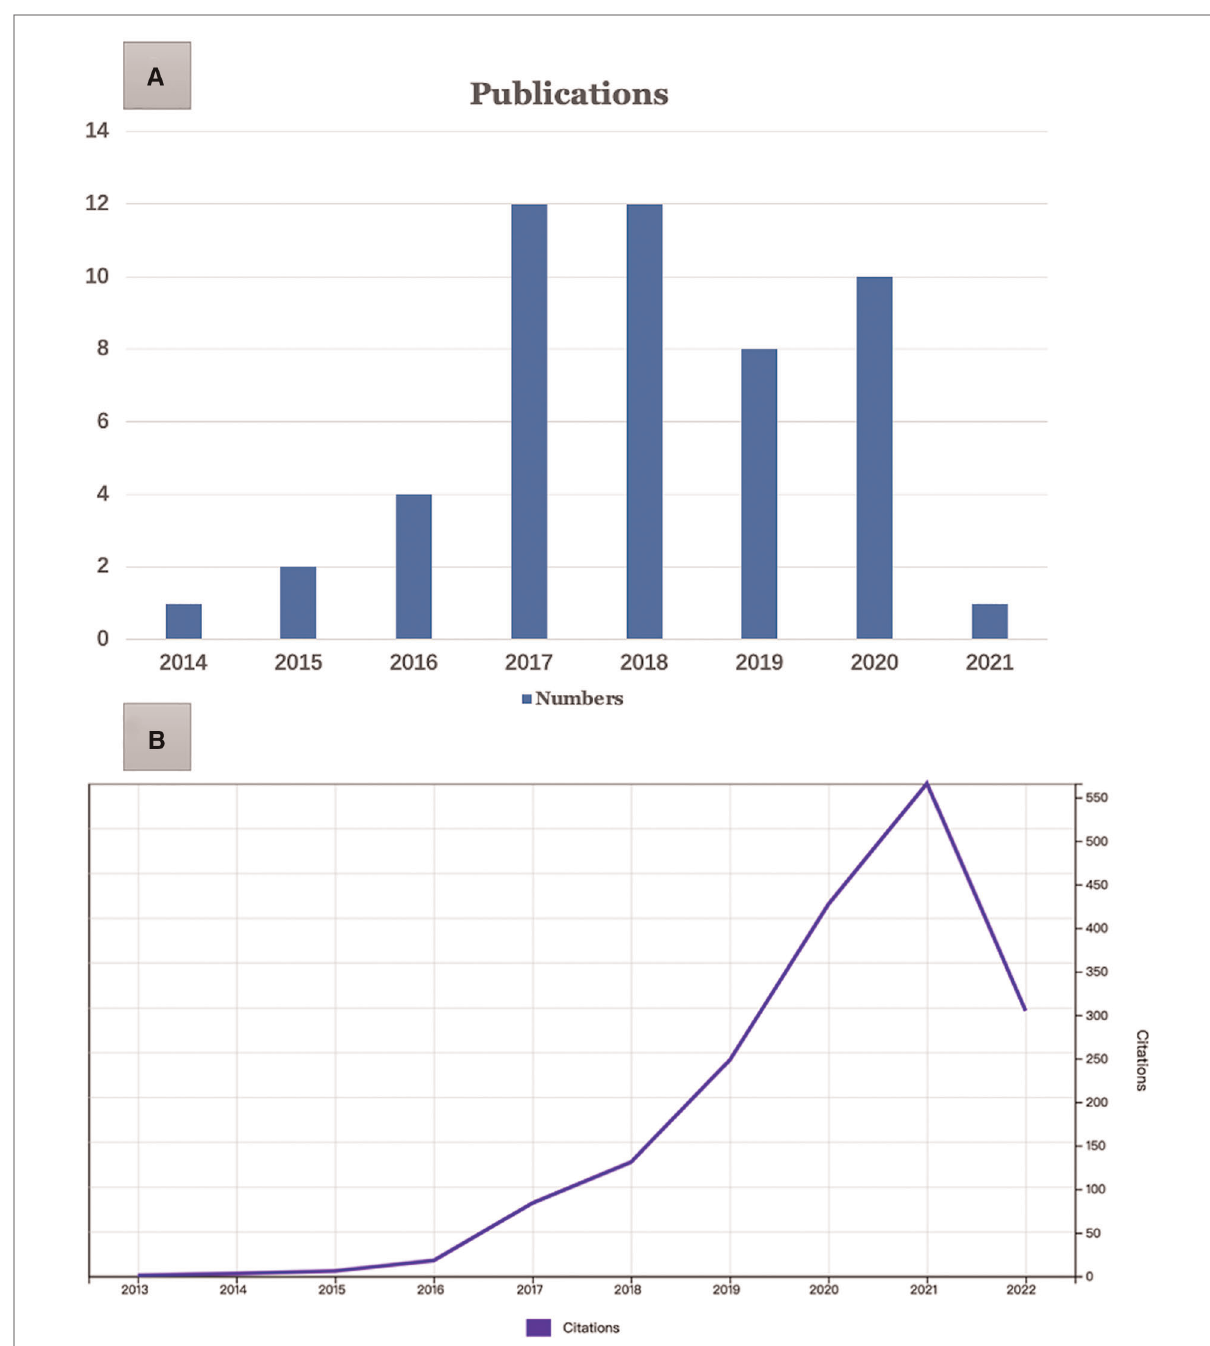
FIGURE 1 Annual number of publications ( A ) and citations ( B